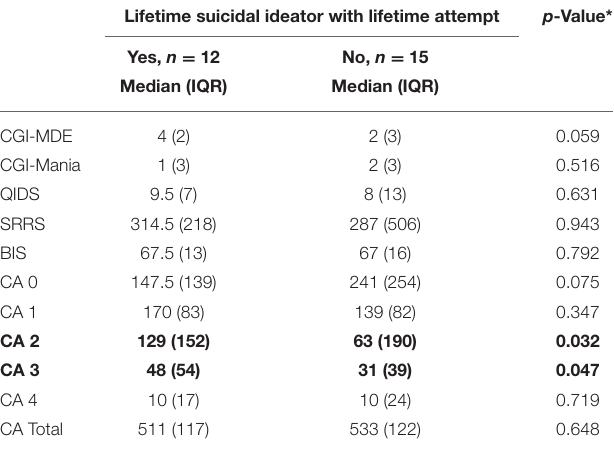
TABLE 4 | Differences in the degree of DNA damage (quantified by comet assay) between lifetime suicidal ideators with previous suicide attempt and without previous suicide attempt.